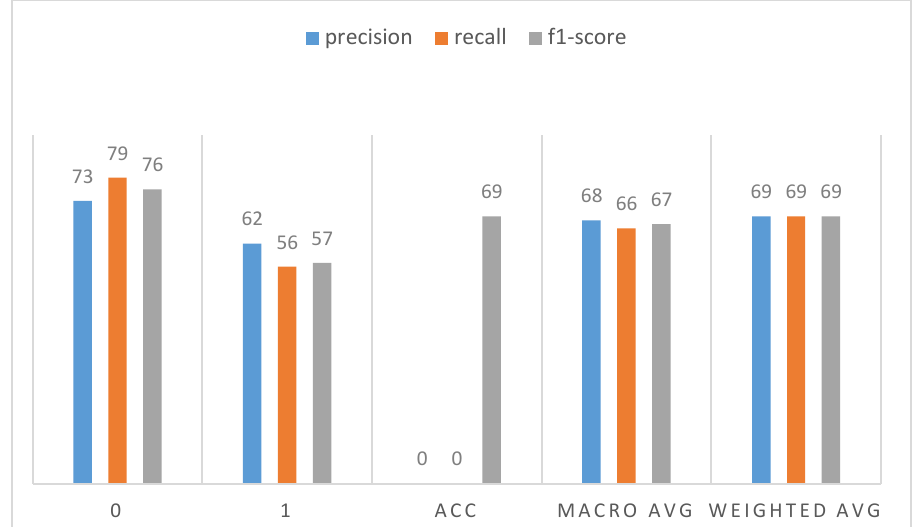
Figure 11. Summary of results for a testing dataset equal to 20% and training dataset of 80%. For the testing dataset size equal to 20% and 80% for training dataset values (Figure 11), the weighted average values leveled off, while the precision value for the lower limit increased from 54% to 62%.